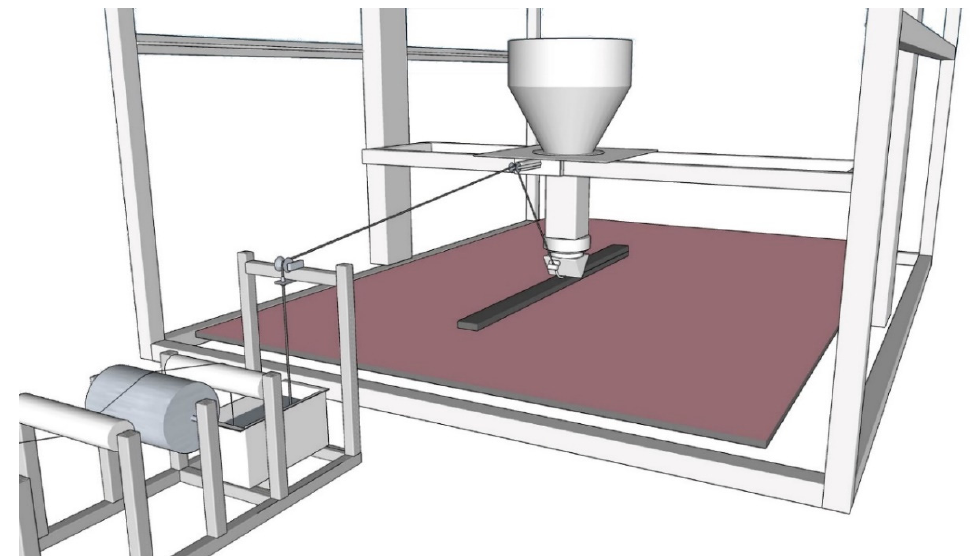
Figure 3. 3D concrete printing with MCF supply from a continuous, stationary impregnation line.